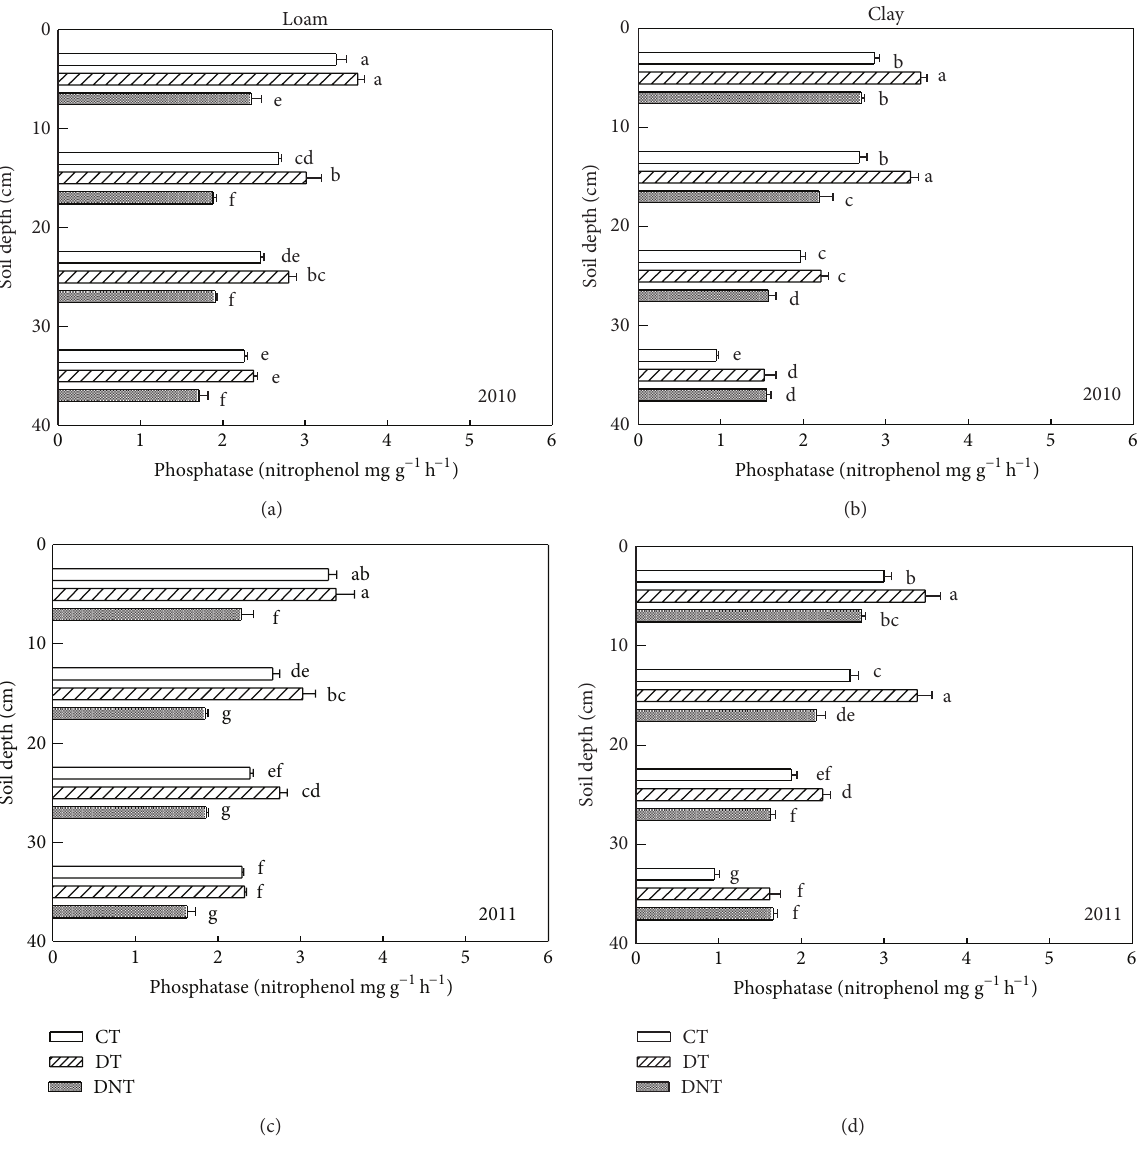
Figure 5: Effects of tillage and straw returning on soil phosphatase activity. Different small letters indicated significant difference at 𝑃 < 0.05 according to Duncan’s test. CT represented conventional tillage, moldboard ploughed to a depth of 20 cm, and straw was returned. DT represented deep tillage moldboard ploughed to a depth of 30 cm and straw was returned. DNT represented deep tillage moldboard ploughed to a depth of 30 cm and straw was